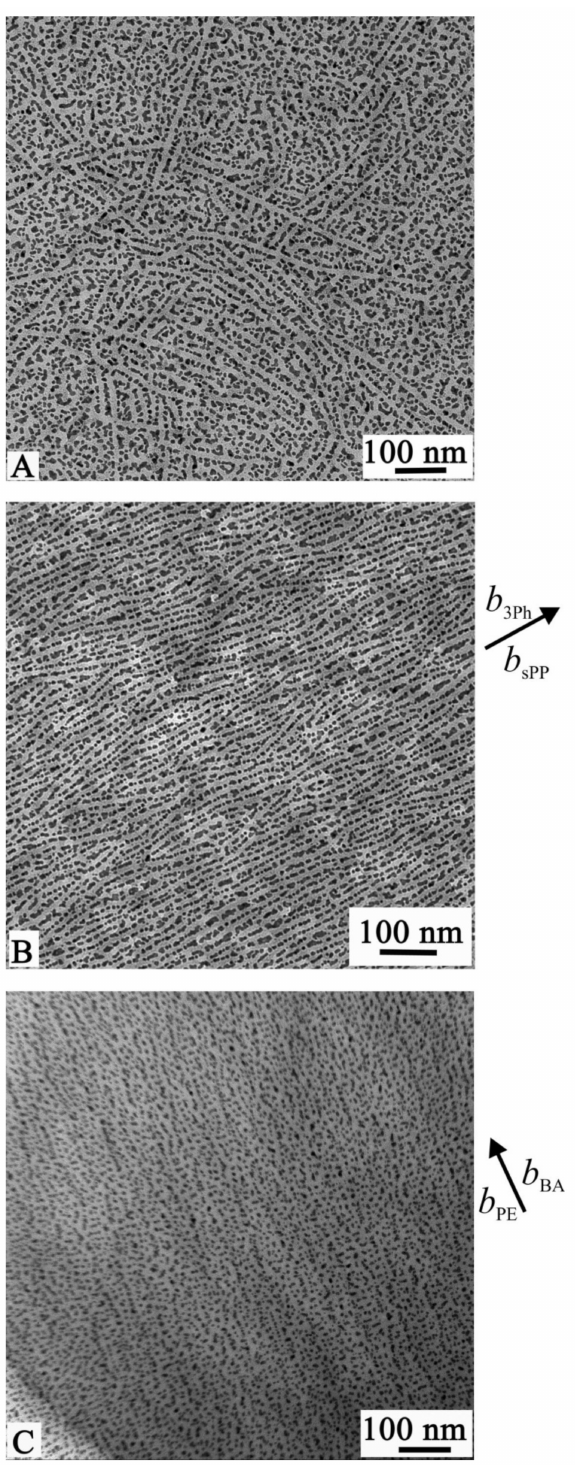
Figure 5. TEM bright-field images of thin films of the sample PE- b -sPP with f PE = 13% crystallized by simple solution casting without epitaxy ( A ) and epitaxially crystallized on the (001) surface of crystals of 3Ph ( B ) and BA ( C